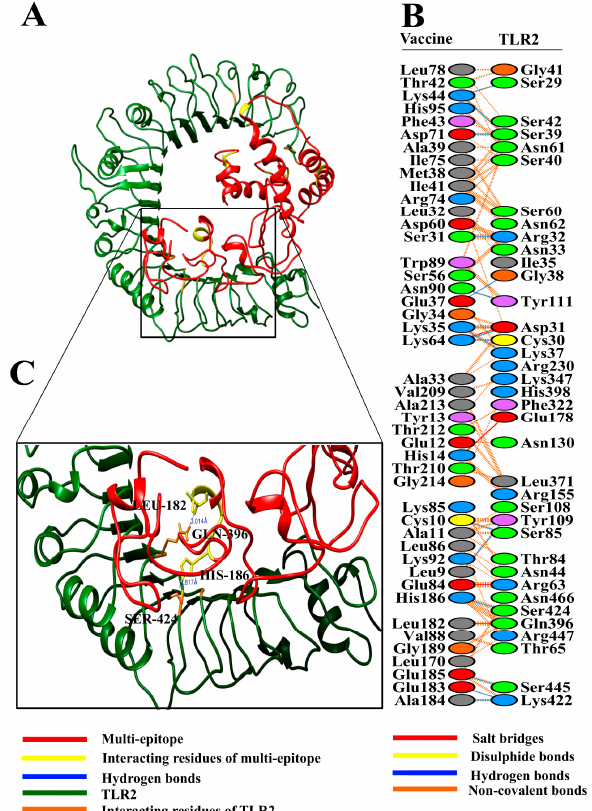
Figure 3. ( A ) Figure obtained after molecular docking showing vaccine construct-TLR2 docked complex. Vaccine construct is shown in red color while TLR2 is shown in green color; ( B ) interacting residues between docked vaccine (chain A) and TLR2 (chain B); ( C ) few prominent hydrogen bonds within vaccine-TLR2 complex are focused.